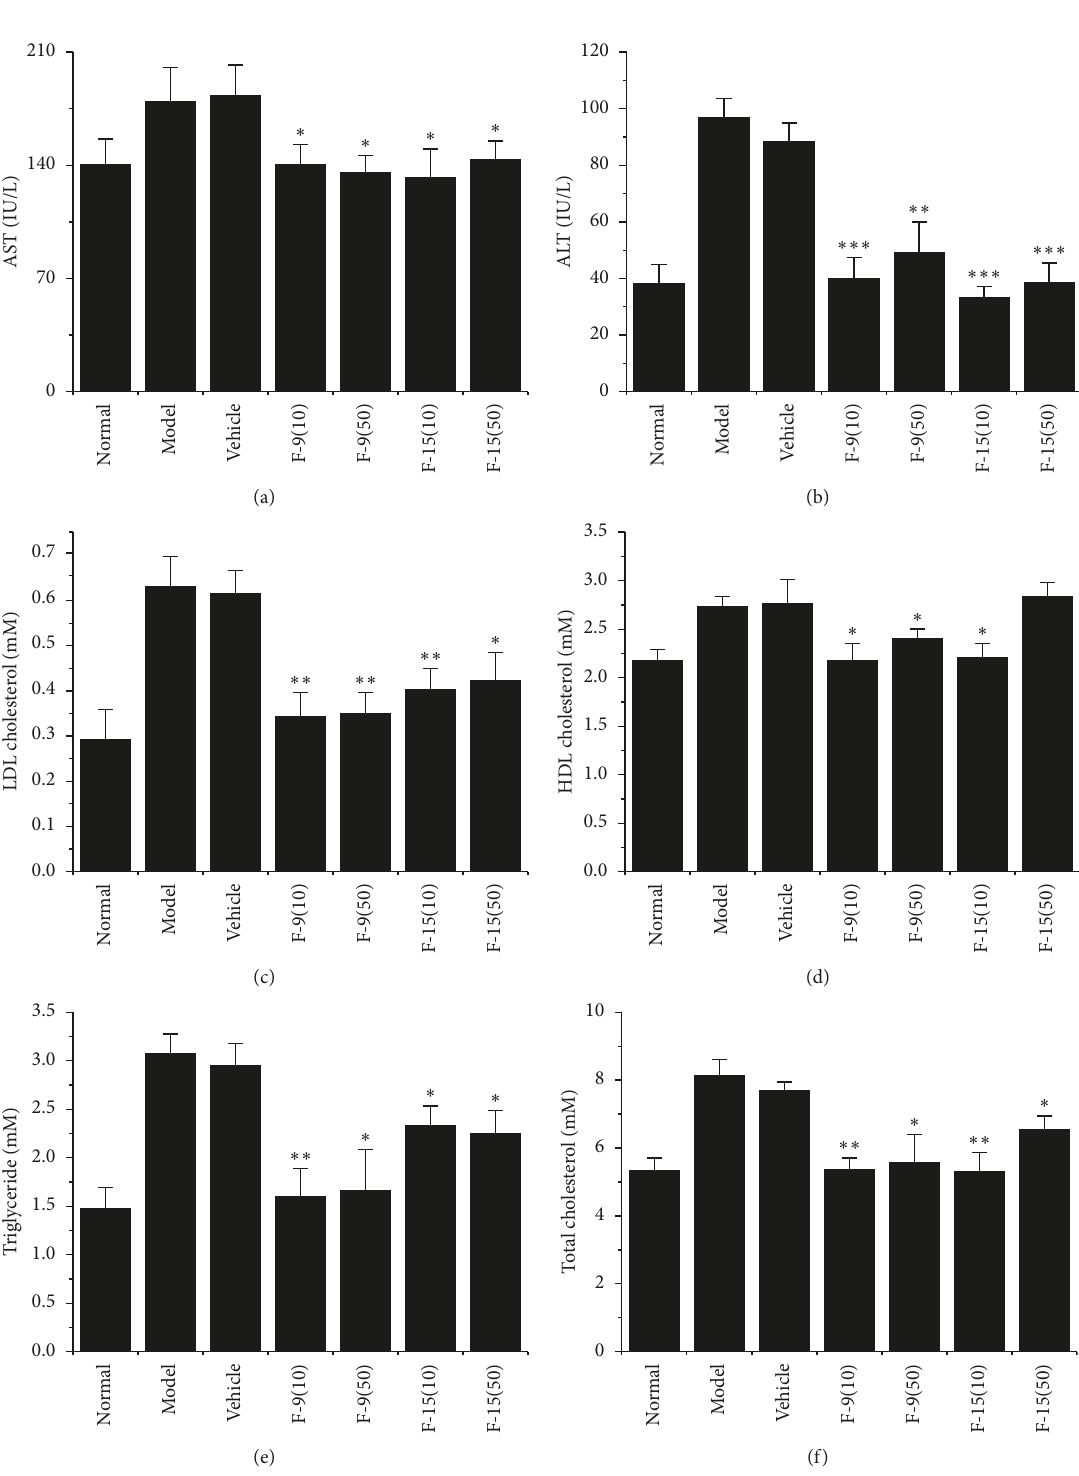
Figure 4: Contents of AST, ALT, TC (total cholesterol), TG (triglyceride), HDL, and LDL in serum.